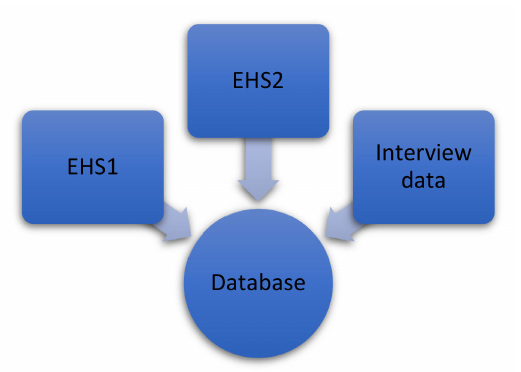
Figure 1. The dataset contains information gathered from two electronic healthcare systems (EHSs) and the qualitative study conducted between January and November